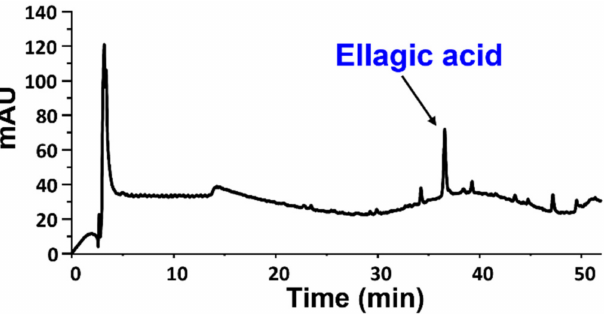
Figure 3. HPLC profile of the DMSO-soluble fraction of chestnut shell